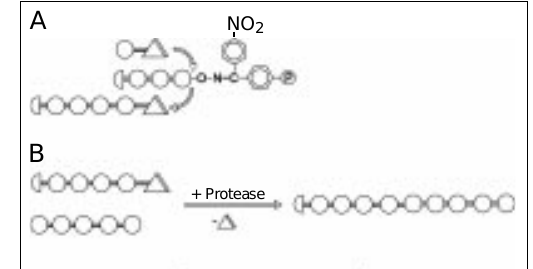
Figure 11 - Combination of solid-phase peptide syn- thesis via oxime resin strategy with trypsin- (A), V8 protease- (B), and chy-